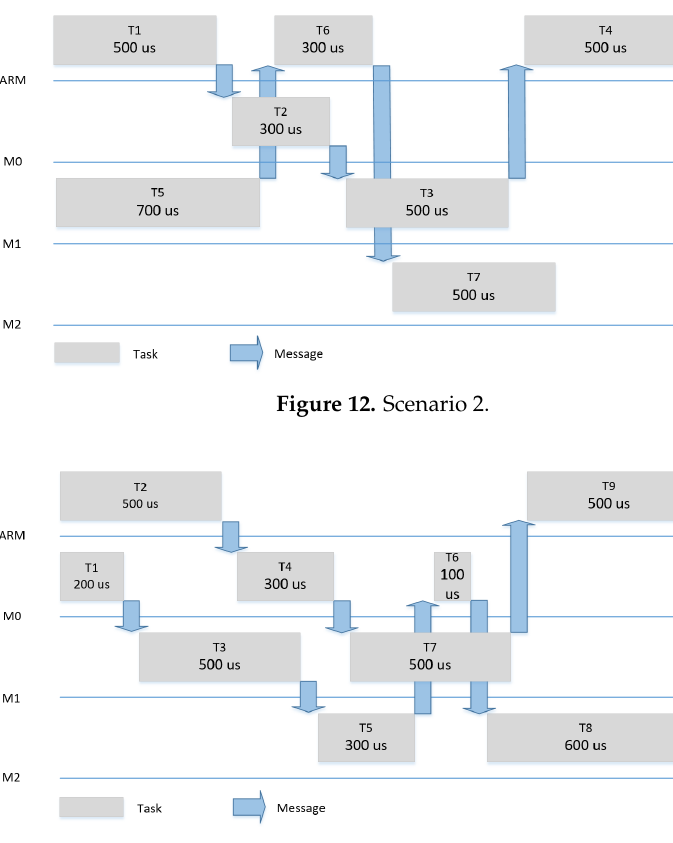
Figure 13. Scenario 3. Table 3. Inputs models for